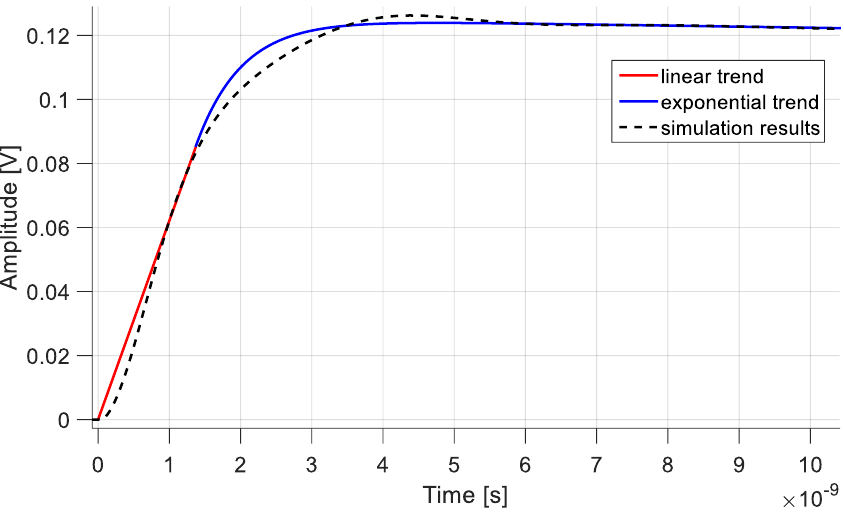
Figure 11. Simulated and predicted step response of the proposed open-loop switched-capacitor integrator.